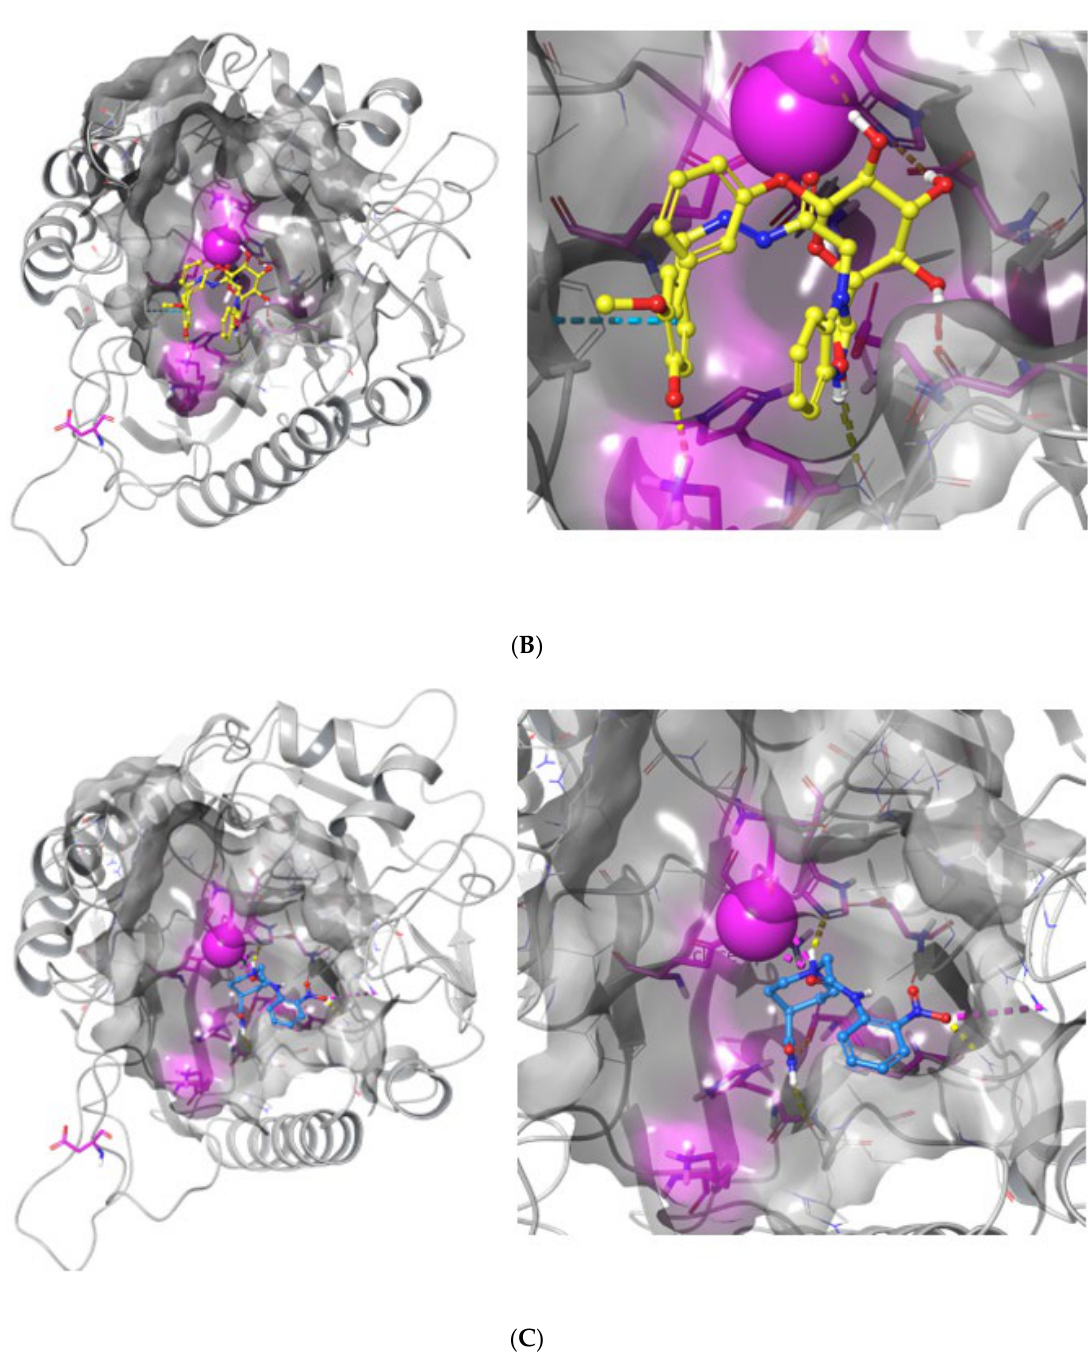
Figure 4. Docking pose of compounds 4011505, 5122895, 5402122, 5784643, and 6924649. ( A ) docking pose for the best two inhibitors, compounds 4011505 (light green) and 5122895 (green), in 3D presentation. ( B ) Docking pose for the two inactives, compounds 5402122, and 5784643 (yellow). ( C ) Docking pose for the activator 6924649, tested in blue. The catalytic Mg 2+ ion is shown as a magenta sphere, with the position of the conserved active site residues important for catalytic activity [26] indicated as magenta shading. The so-called DK-switch [26] with residue D430 is indicated as a magenta sidechain for orientation. The surface of the active site pocket is overlaid on the ribbon structure of SMase2. The insert shows a close-up of the active site region in 4a, 4b and 4c. To allow for a more readily readable insight into individual interactions that summa- rizes the interaction data from the 3D poses, Figure 5A–H illustrates the 2D interaction